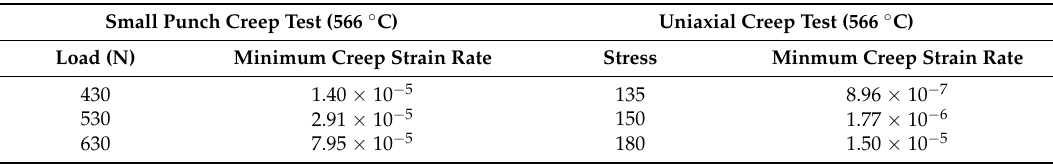
Table 1. Minimum creep strain rates under each load or stress levels of small punch creep test and uniaxial creep test.